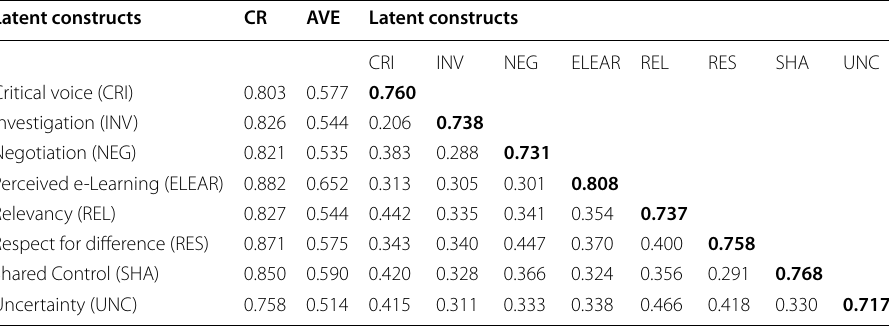
The diagonal part (in bold) is the values of the square root of AVE for every construct